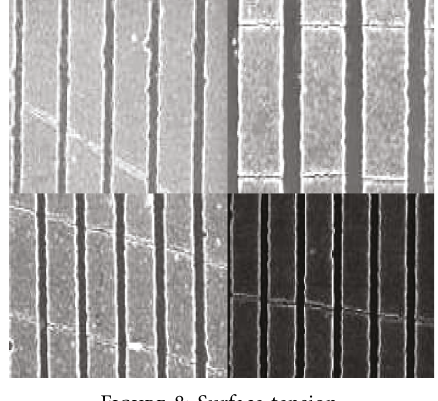
Figure 8: Surface tension. Table 3: Commercialization attribution